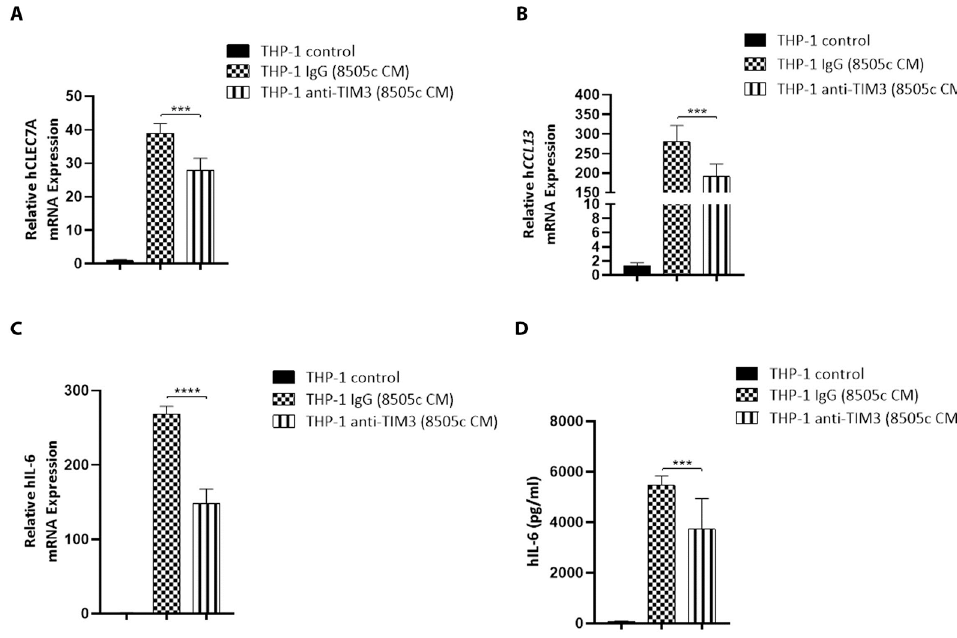
Figure 5. TIM3 modulates M2-like macrophage polarization in vitro. ( A – D ) THP-1 cells were incubated with complete media (THP-1 control) or treated with 8505c cell-derived CM (THP-1 (8505c CM)) in the presence of isotype control IgG or anti-TIM3 blocking antibody for 24 h. hCLEC7A ( A ), hCCL13 ( B ), or IL-6 ( C ) mRNA levels were measured by RT-qPCR. ( D ) The supernatant was collected, and IL-6 was detected by ELISA. Data are expressed as mean ± SD. *** p < 0.0005, **** p < 0.0001.